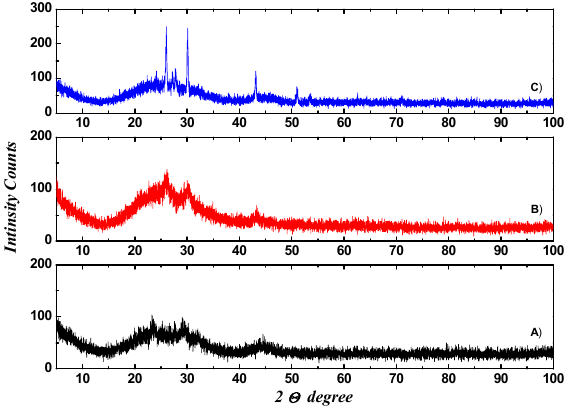
Figure 4. Lebail fit analysis of (Bi